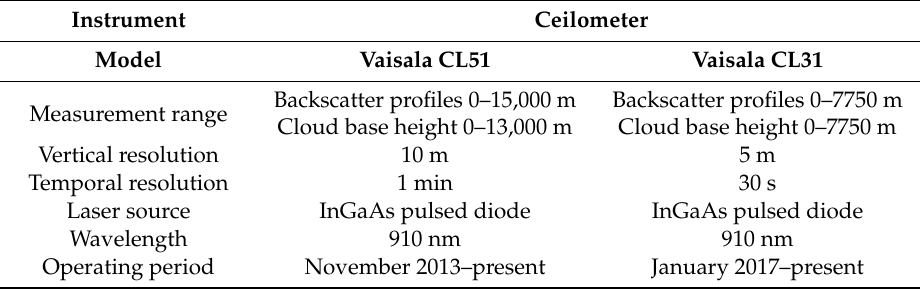
Table 1. Technical details of the ceilometers at Seoul and Taean stations.